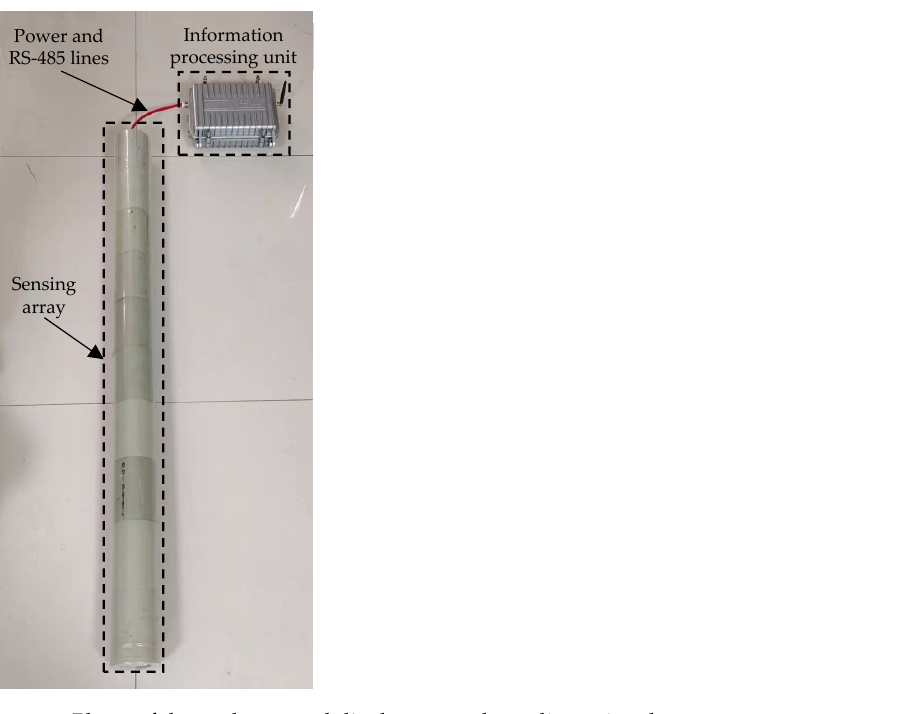
Figure 1. Photo of the underground displacement three-dimensional measurement system.